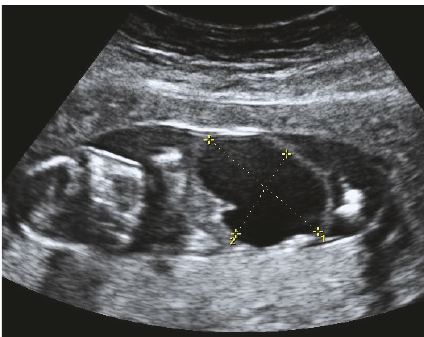
Figure 1: Ultrasonographic findings of the fetus at 14 weeks of ges- tation. A fetal intra-abdominal cyst (34 × 24 mm in size) and oligo- hydramnios are observed.